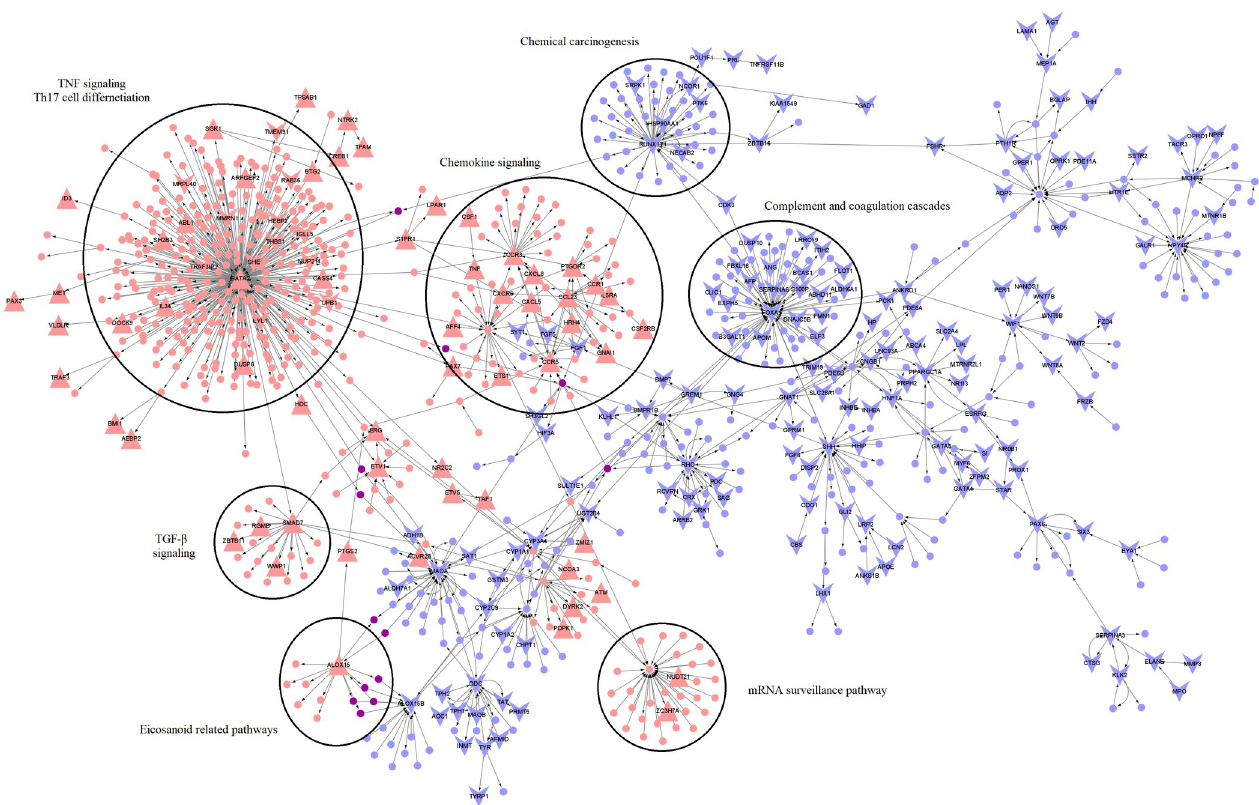
Fig 2. TopNet for RHD vs ARF. The red nodes represent genes in the top active network, the blue nodes represent nodes of the top repressed network, and the purple nodes indicate nodes common to both. Upper-facing triangles represent upregulated genes, and lower-facing triangles indicate nodes that are downregulated in RHD compared to ARF. Functional enrichment of some hub nodes such as GATA2, CCR3, SMAD7, and ALOX15 are also shown.